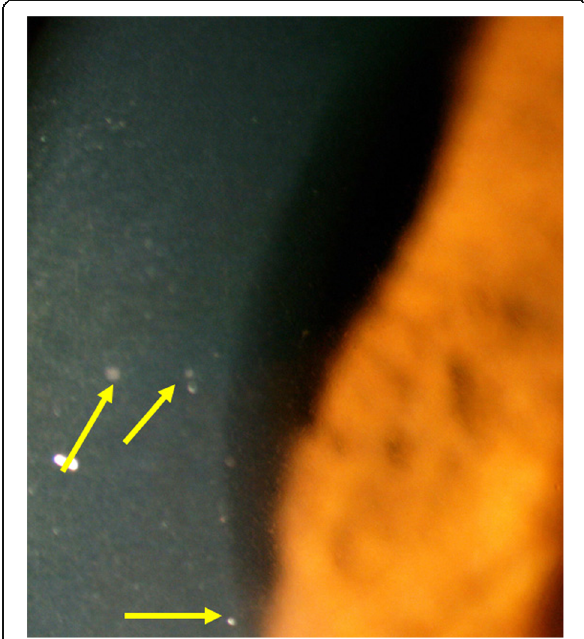
Fig. 5 Recurrence of VKH disease after 6 inflammation free years. While the initial-onset disease was non-granulomatous, mutton-fat KPs were seen during post-vaccine recurrence OD (yellow